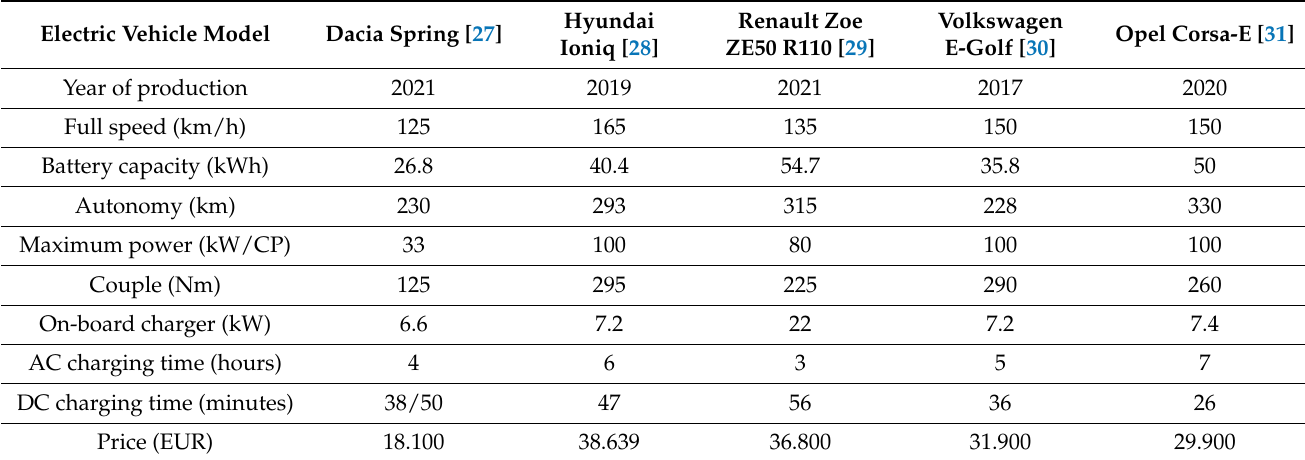
Table 2. Technical characteristics of electric vehicles.